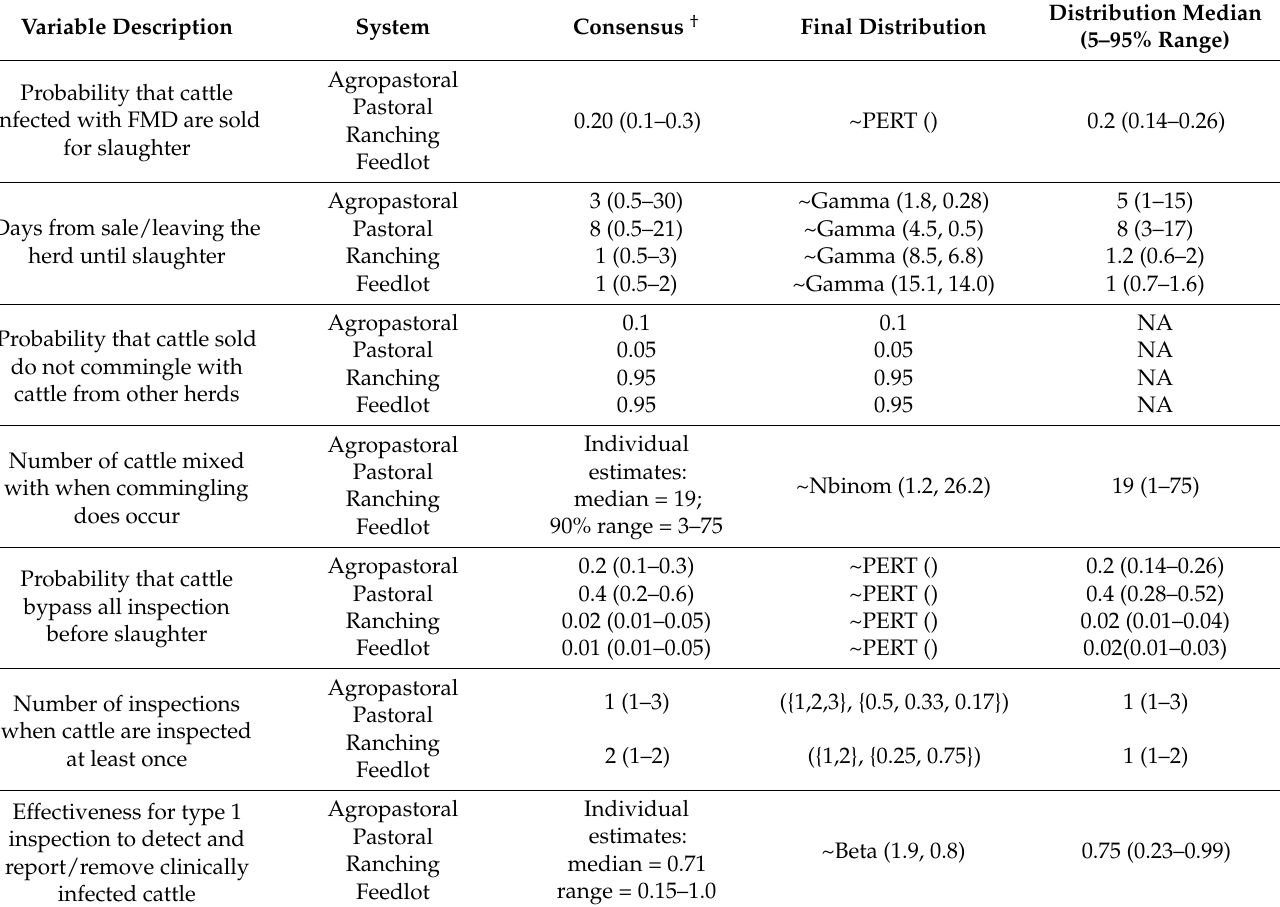
Table A1. Group consensus and final distribution for each variable for cattle production systems in Kenya. Variable